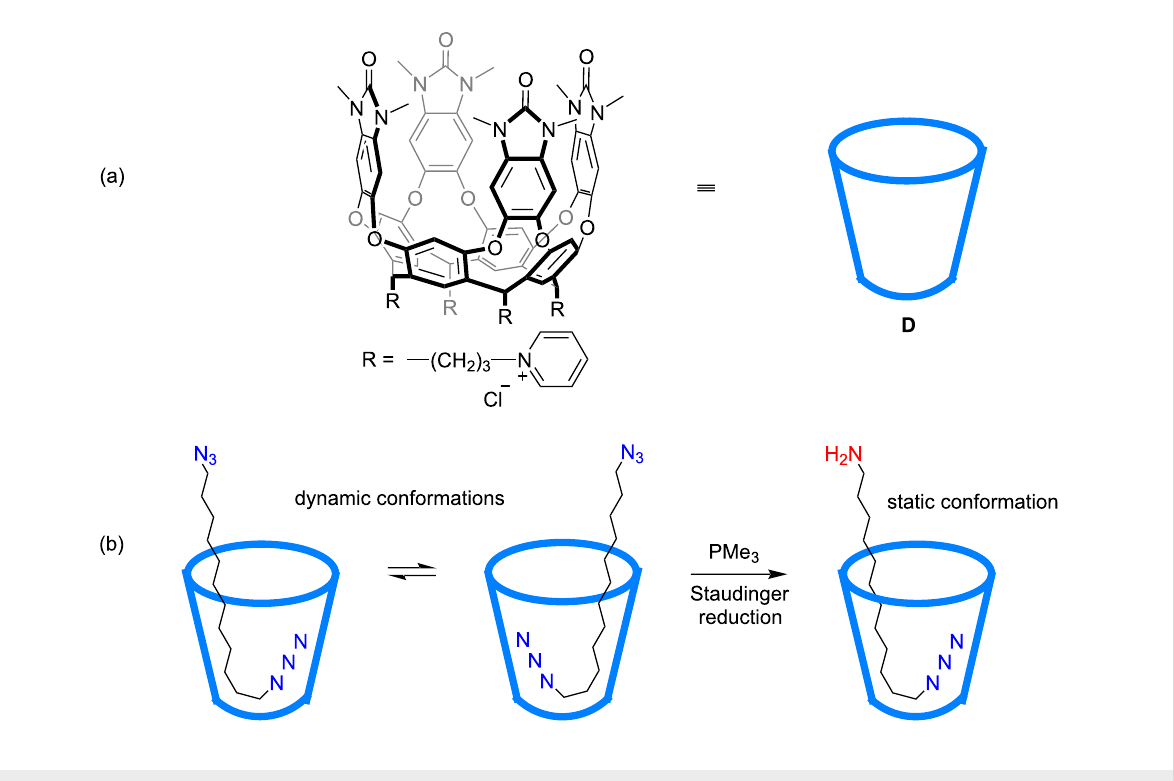
Figure 5: Selective reduction of an α , ω -diazide compound mediated by water-soluble cavitand D .